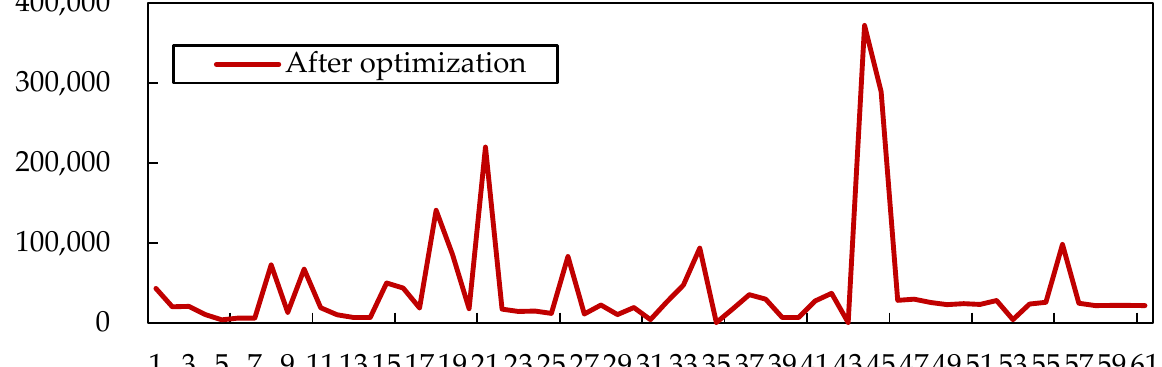
Figure 7. Distribution and convergence accuracy between availability and AFMC. (AFMC: Aircraft fleet maintenance cost). ( a ) Distribution law; ( b ) Convergence accuracy.